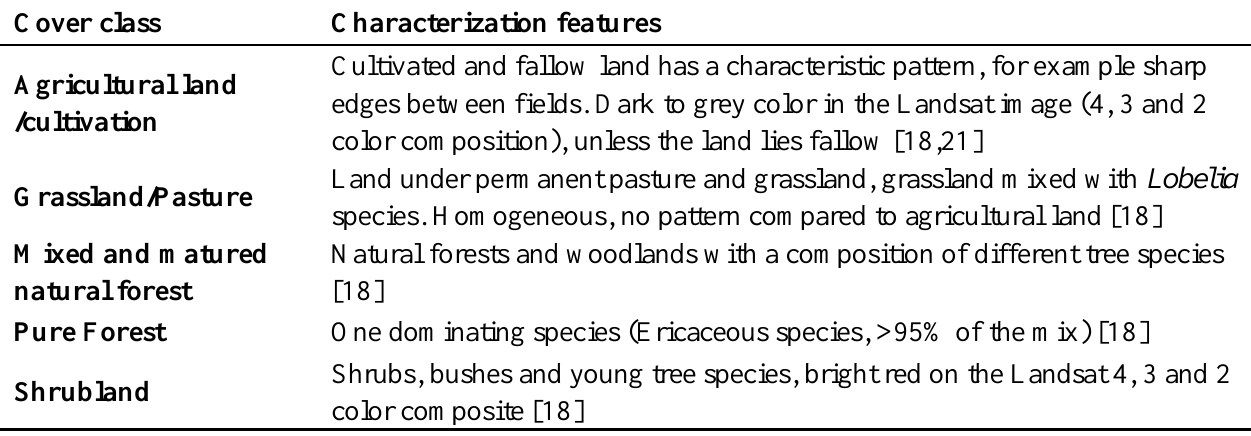
Table 1. Land cover classes used in the classification